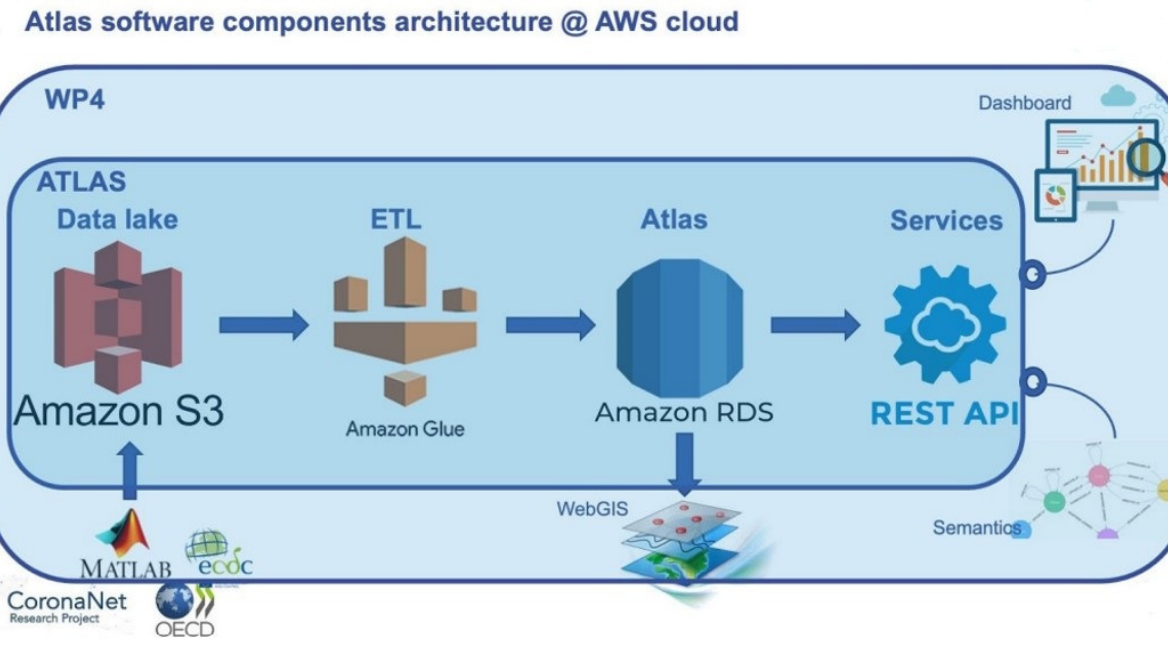
Figure 4. Initial Atlas interface. 4.1. WebGIS Map The WebGIS Map allows to visualize and explore the data collected in the Atlas da- tabase in a classic GIS way, i.e., with layers that can be activated, deactivated and over- lapped on a geographic map. In particular, a menu on the right side of the page allows to add layers of data, navigating them in a directory-like system where they are categorized according to data source and data type. Once a layer is selected, the relative data,